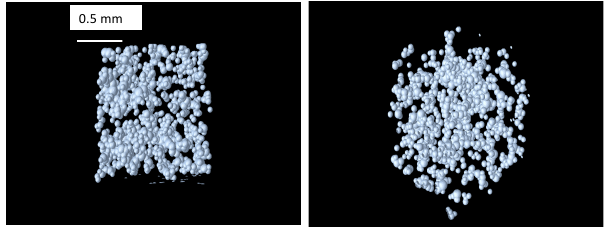
Figure 3: Perspective views of the sphere based pore space of the sand. The spheres whose Fig. 3. Perspective views of the sphere-based pore space of the sand. The spheres whose radii were higher than 10µm were displayed. radius were higher than 10 µ m were displayed.